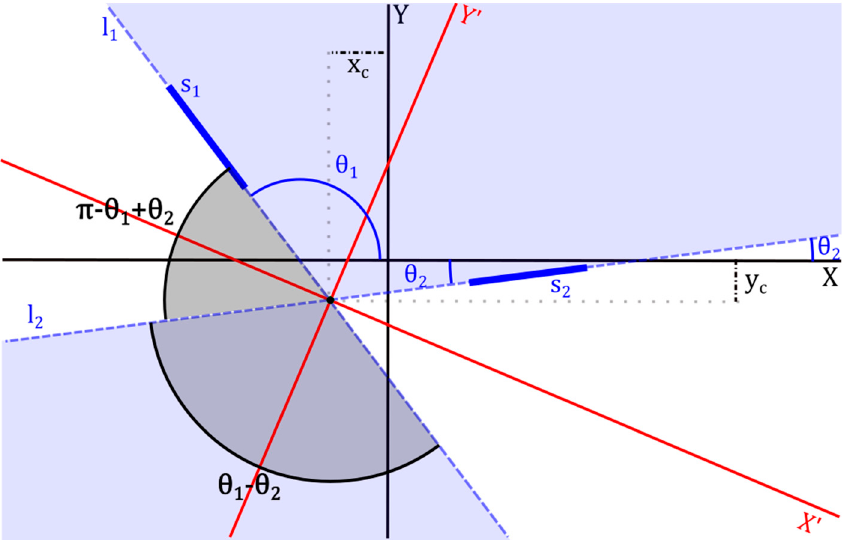
Figure 1. Two nonparallel segments (blue lines), best fitting straight lines to each segment (dashed blue lines), intersection ( x c , y c ), and bisectors (red lines).